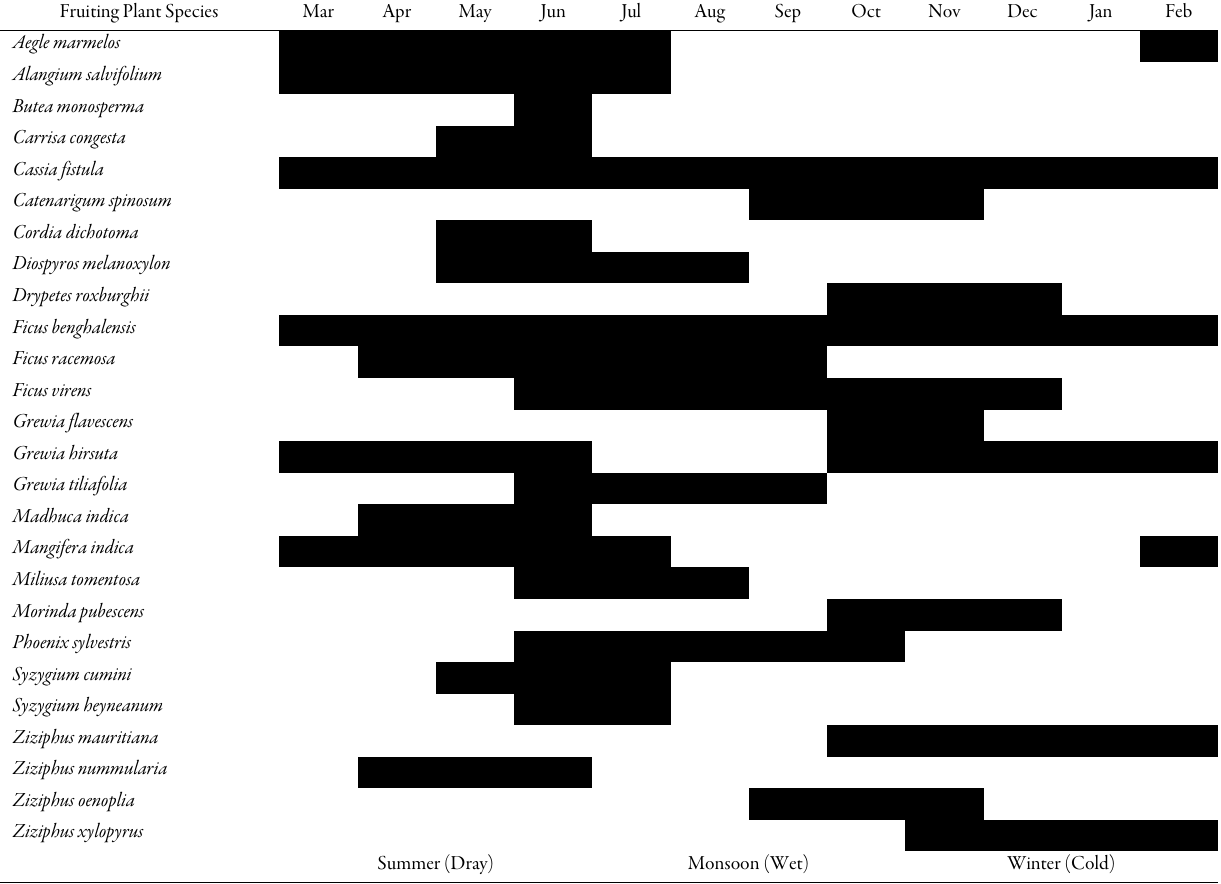
Table 5. Fruits availability in different seasons in a year for sloth bear Fruiting Plant